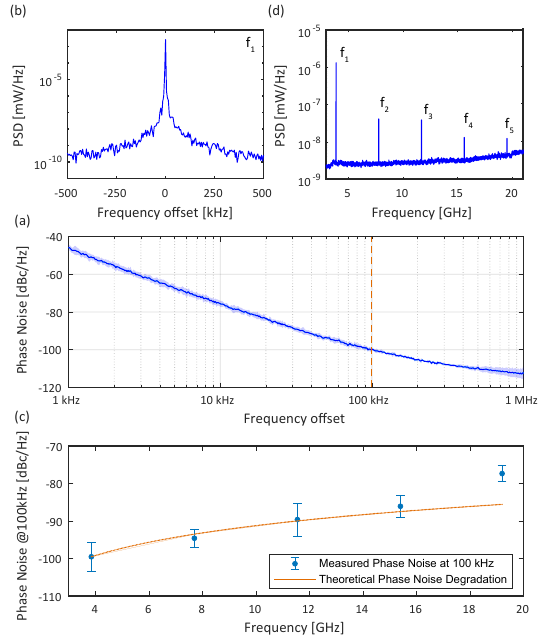
Figure 2. (a) Linear scale of the first harmonic centered at 3.87 GHz. (b) RF spectra of the generated OFC. (c) Mean phase noise of the generated microwave tone. (d) Phase noise of the di ff erent harmonics of the OFC with the theoretical phase noise degrada- tion with respect to that of the 1st